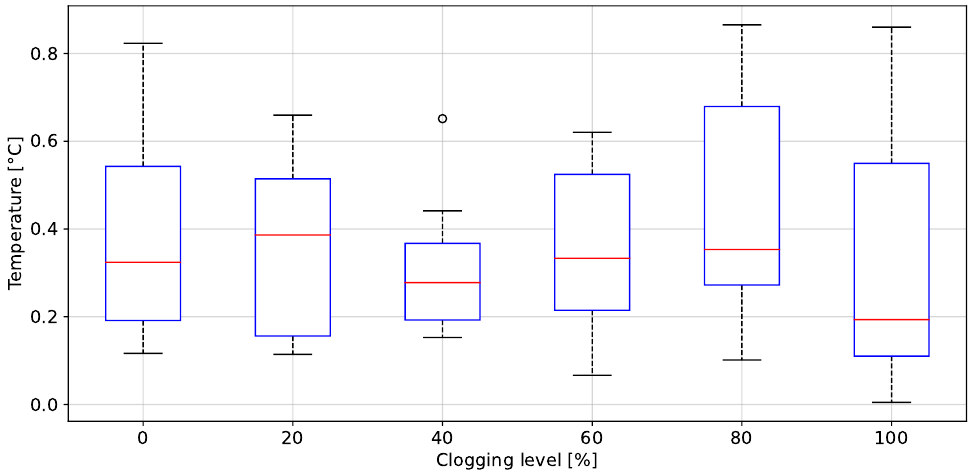
Figure 22. Peak to peak values of temperature as a function of the clogging